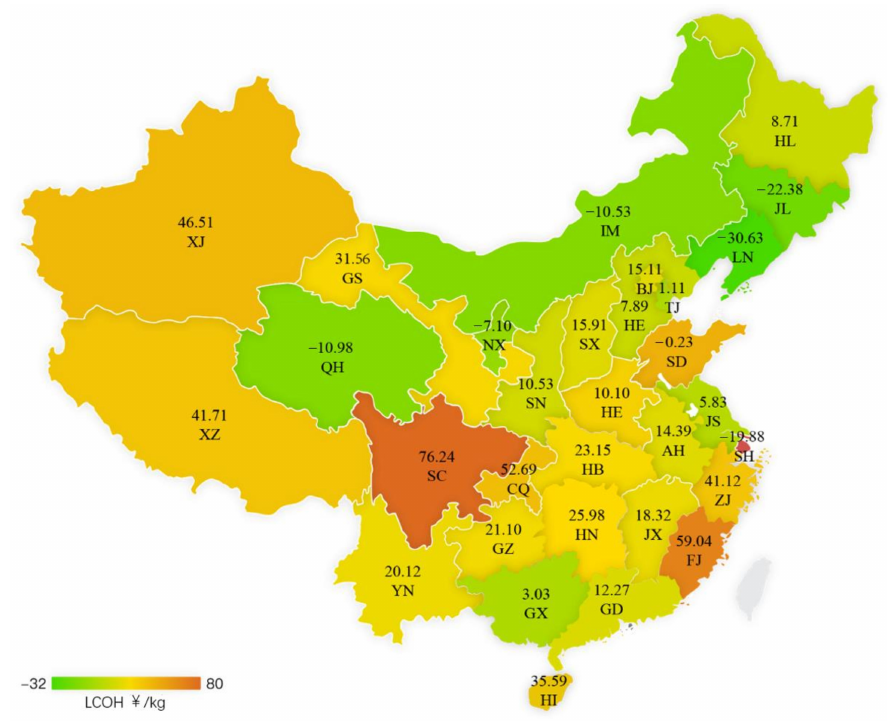
Figure 7. LCOH heat map of 50 MW sample wind hydrogen coupled power plants in each province with 3000 kg daily hydrogen